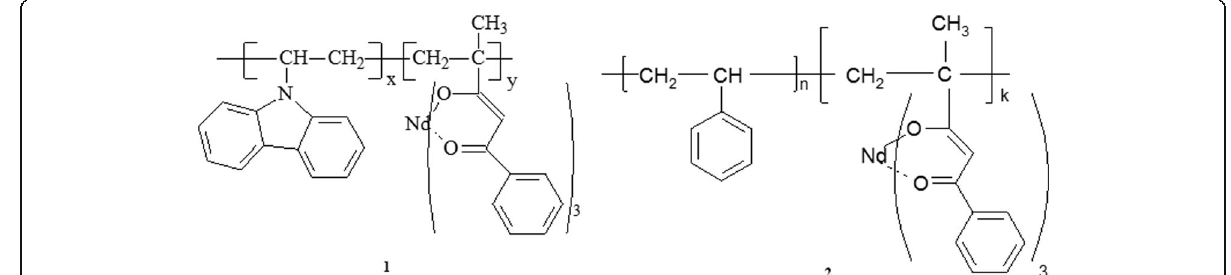
Fig. 1 The fragments of copolymers structure ( 1 ) [Nd(mphpd) 3 ] n ⋅ [VK] m and ( 2 ) [Nd(mphpd) 3 ] n ⋅ [styrene]